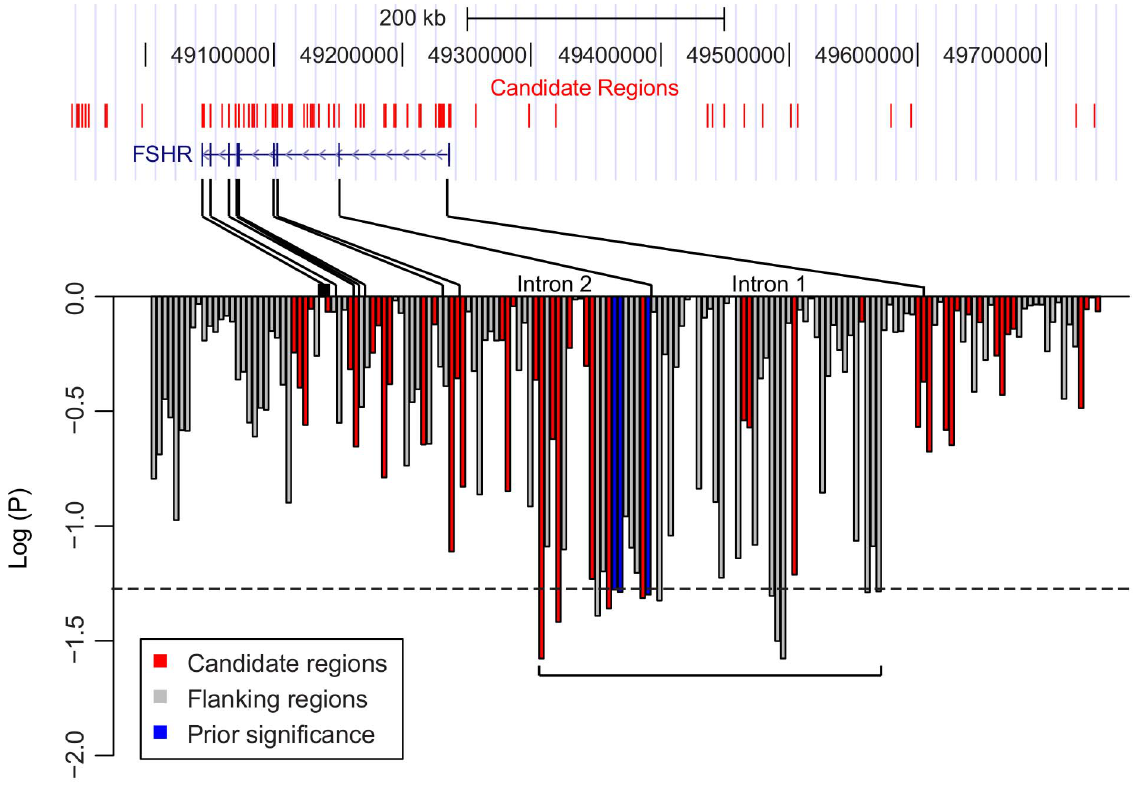
Figure 2. Fine-map of the association between common variants and preterm birth. Each of 169 variants with minor allele frequency greater than 5% was tested for the allelic association with pre-term birth using a two-proportion Z-test. The log 10 of the P-value is shown for each SNP ordered by is position at the FSHR locus, shown above, with lines indicating intron boundaries and red ticks indicating the positions of 67 candidate regions sequenced. Bars are red for SNPs within candidate regions, gray for SNPs in flanking regions, and blue for those found significant in [16]. The dashed horizontal line indicates the least significant P-value of the three tag SNPs in blue. doi:10.1371/journal.pone.0078032.g002 PLOS ONE |